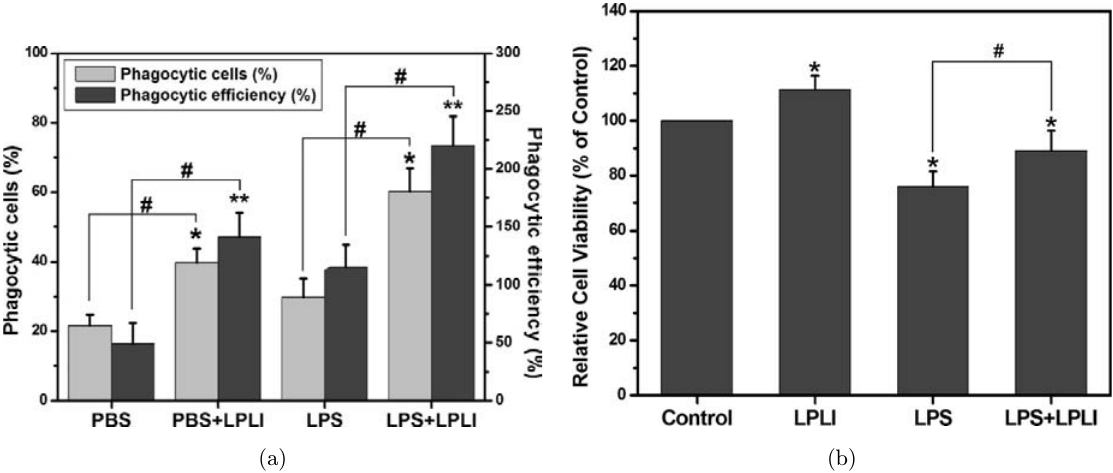
Fig. 1. E®ects of LPLI on phagocytic function of activated microglial cells. BV-2 cells with or without LPLI (20 J/cm 2 ) treatment were incubated with microspheres for indicated time. (a) Quanti¯cation of LPLI-mediated microglial phagocytosis; and the number of microspheres taken up per BV-2 cell at 30 min was measured. ( n ¼ 4; * p < 0 : 05 and ** p < 0 : 05 vs corresponding control cells, # p < 0 : 05 vs indicated cells). (b) Quanti¯cation of cell viability by using CCK-8 assay after indicated treatments. ( n ¼ 6; * p < 0 : 05 vs corresponding control cells, # p < 0 : 05 vs indicated